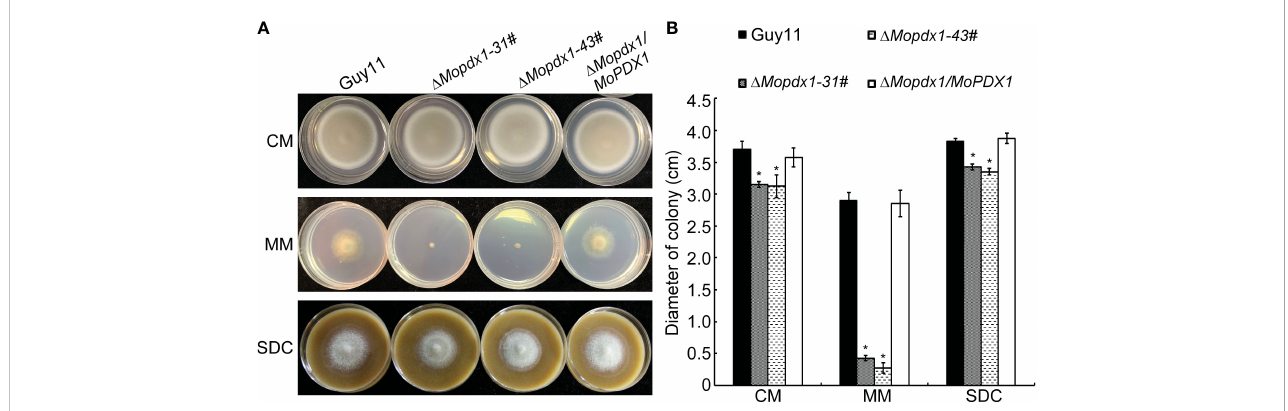
FIGURE 2 Deletion of MoPDX1 affects the vegetative growth of M. oryzae . (A) Colony morphology of Guy11, two MoPDX1 deletion mutants, and complementary strains after growth at 28°C on CM, MM, and SDC media for 7 days. (B) Colony diameters of indicated strains on three kinds of media after 7 days post inoculation (dpi) at 28°C. Experiments were repeated three times with similar results. Error bars represent the standard deviation. Asterisks represent signi fi cant differences (LSD and Student-Newman-Keuls test, p